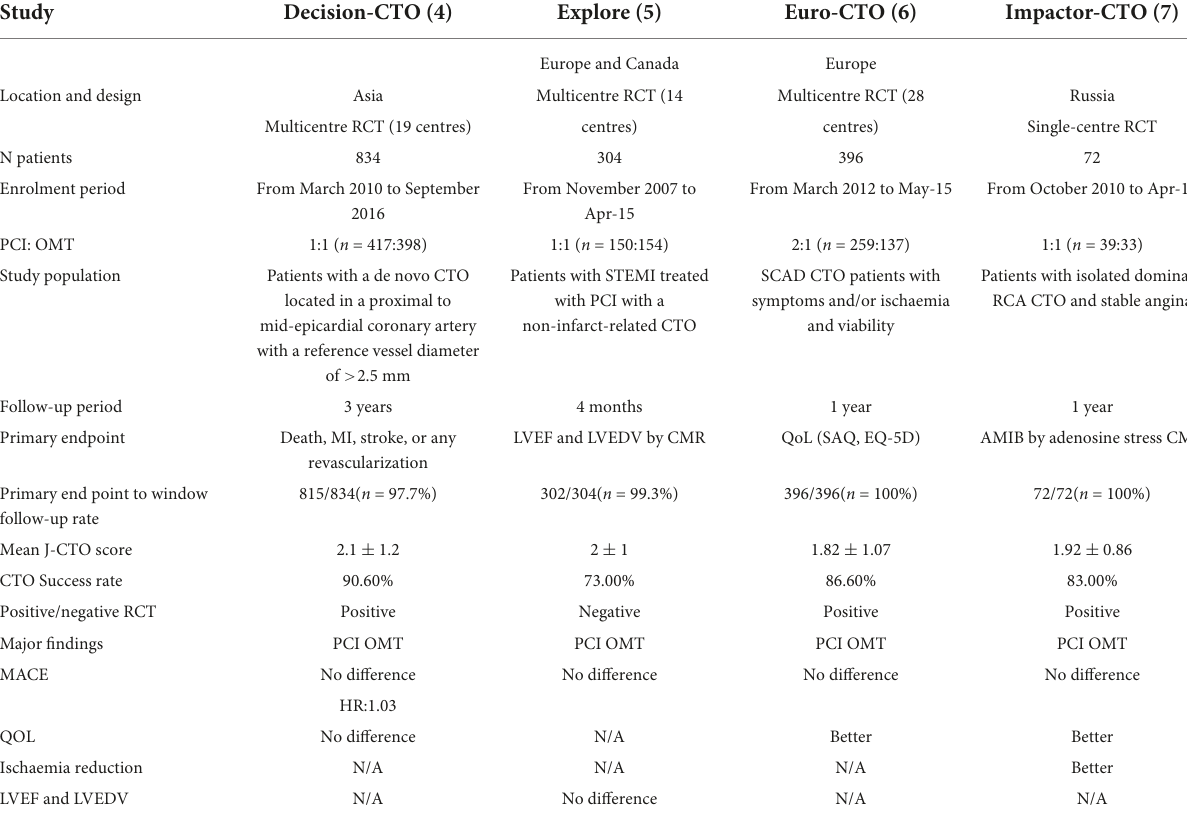
TABLE 1 Major Findings of the Published RCTs comparing PCI vs. OMT in CTO